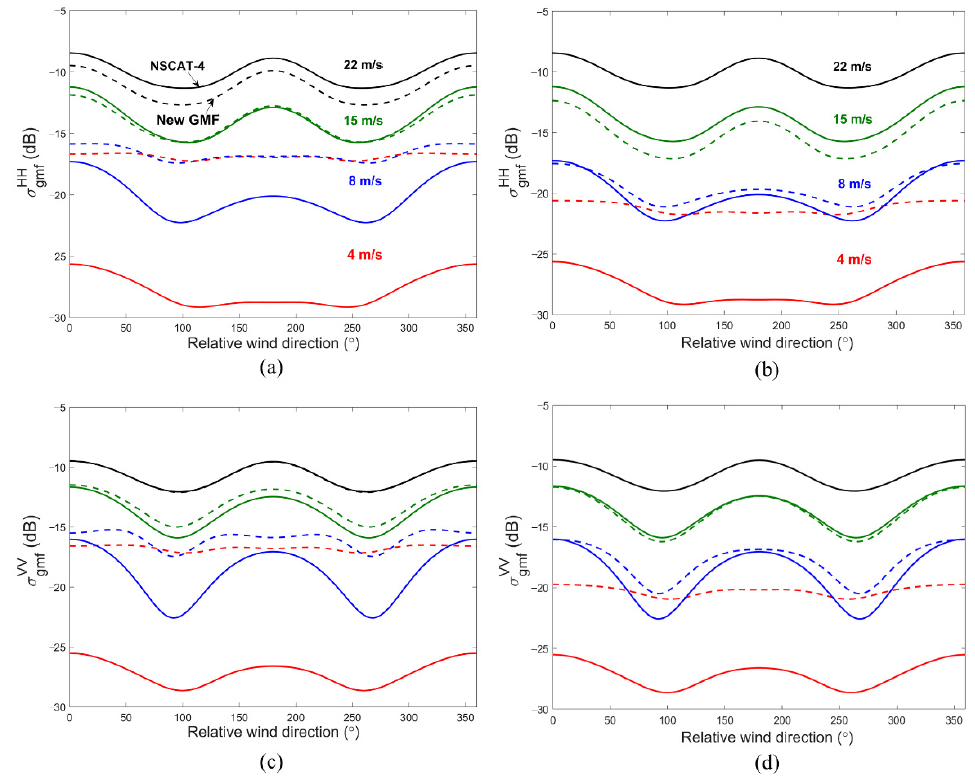
Figure 5. GMF comparisons between σ gmf _ rain (in dashed lines) and σ nscat − 4 (in solid lines) for 4 m/s, 8 m/s, 15 m/s, and 22 m/s, respectively. The first row is for HH polarization and the second row is for VV polarization. ( a ) HH polarization and PR06 at 0.283, ( b ) HH polarization and PR06 at 0.306, ( c ) VV polarization and PR06 at 0.283, ( d ) VV polarization and PR06 at 0.306.